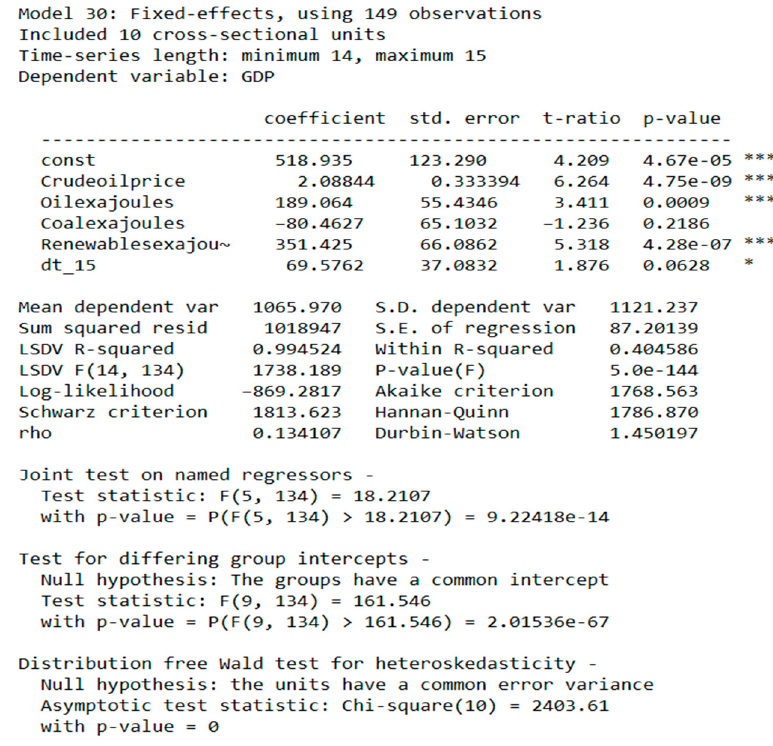
Figure 19. Panel models.